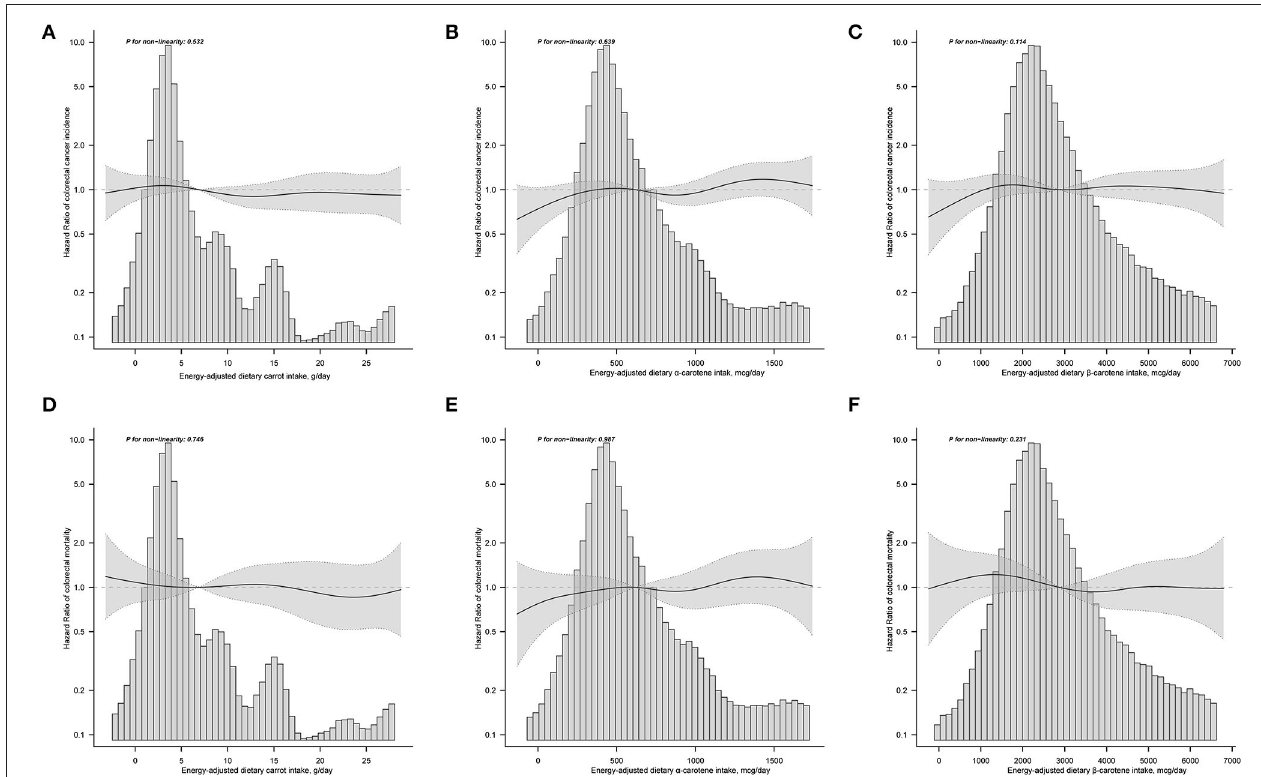
FIGURE 2 | Does-response analyses for the associations between energy-adjusted dietary carrot intake (A) , dietary α -carotene intake (B) , dietary β -carotene intake (C) and colorectal cancer incidence; and the associations between energy-adjusted dietary carrot intake (D) , dietary α -carotene intake (E) , dietary β -carotene intake (F) and colorectal cancer mortality were performed with smooth curve fitting using the generalized additive model. Hazard ratios and 95% confidence interval were calculated by the fully-adjusted multivariable Cox regression model, including age, sex, race, trial arm, marital status, BMI, educational level, aspirin use, cigarette smoking, alcohol drinking, diabetes, family history of colorectal cancer, energy intake from diet, supplemental Beta-Carotene, supplemental Calcium, supplemental Vitamin A, supplemental Vitamin C, supplemental Vitamin D, and Supplemental Vitamin E. Solid lines represent point estimates and dashed lines represent corresponding 95% confidence intervals. The histograms show the percentage of participants belonging to each level of specific energy-adjusted dietary carrot/carotene intake.